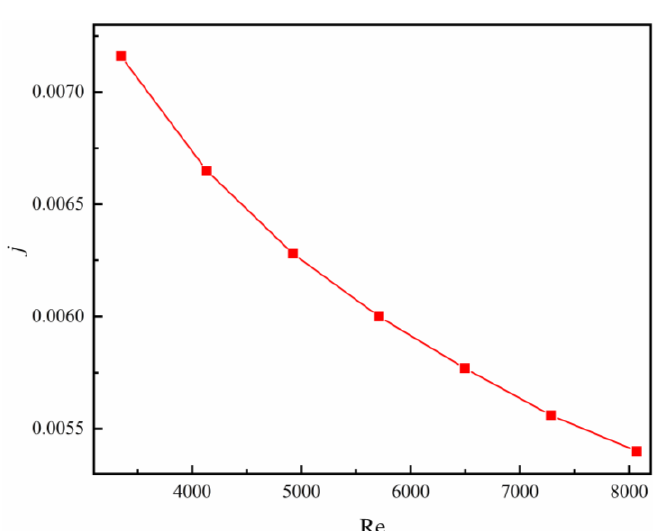
Figure 18. Distributions of heat transfer factor j versus Reynolds numbers.